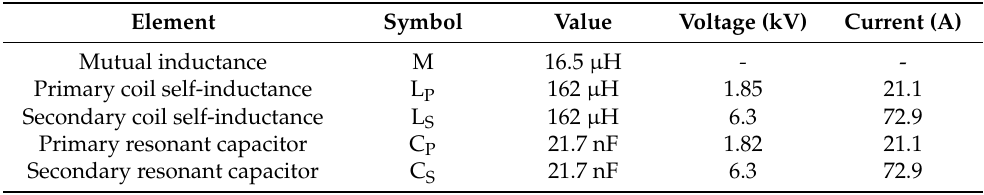
Table 4. Sizing values of the BWV2H coupling coils and compensation networks.